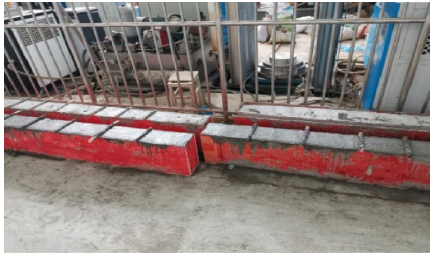
Figure 4: Post-maintenance.